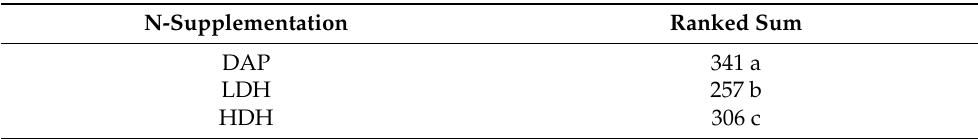
Table 3. Ranked sum for the panelists’ preference among the different nitrogen-supplemented